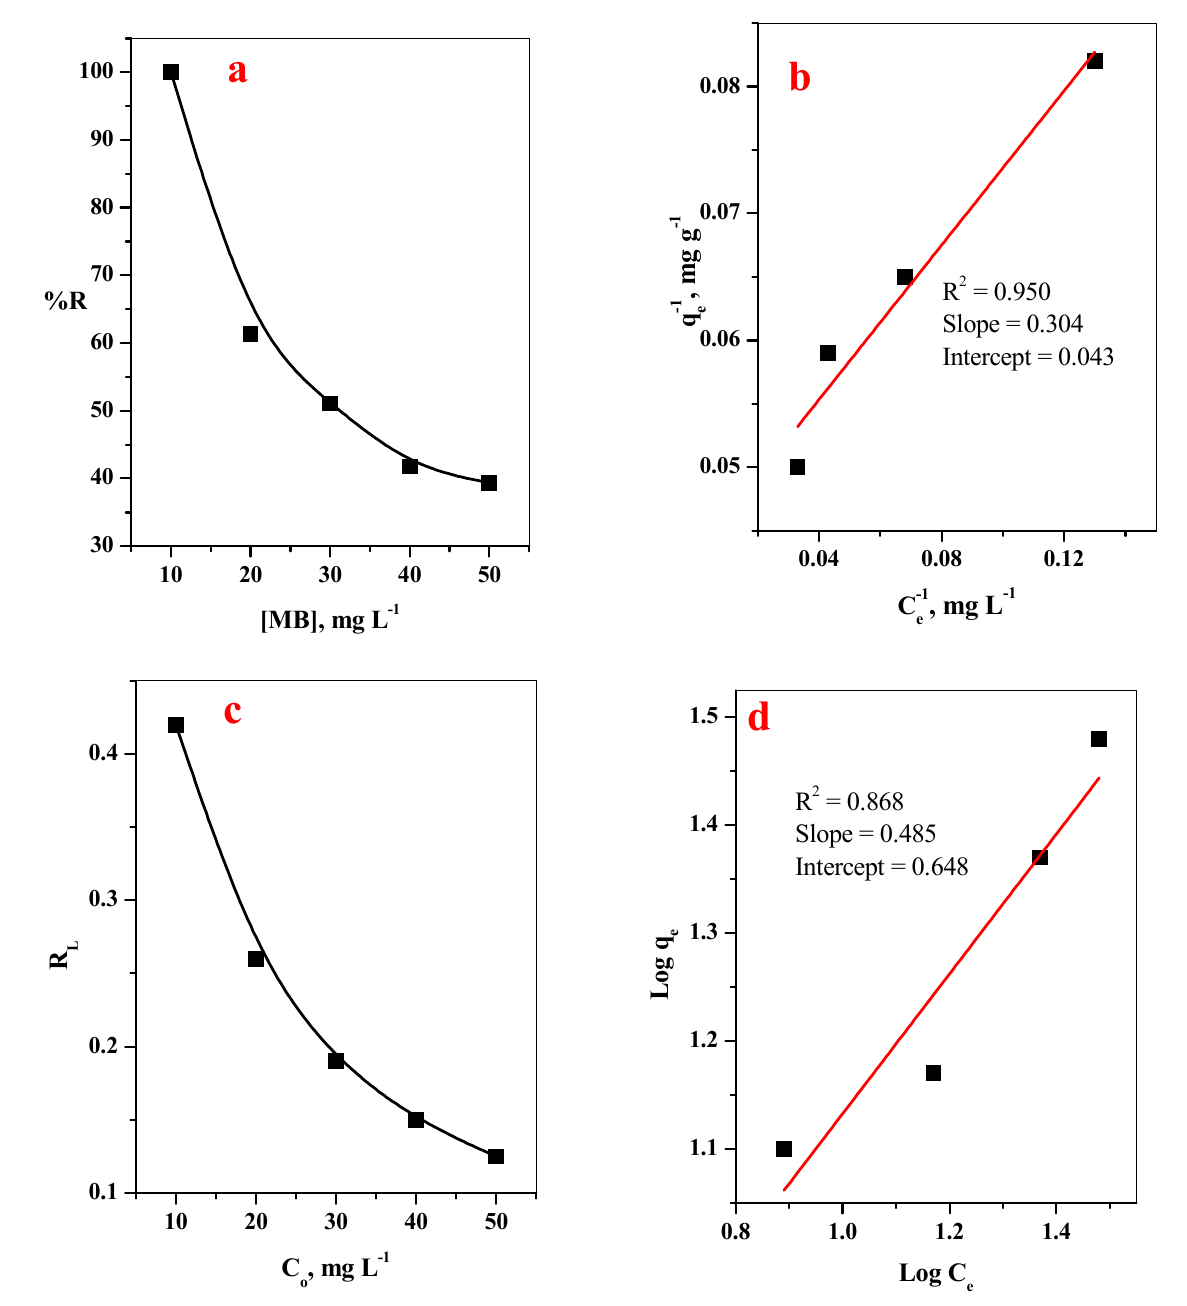
Figure 7. Effect of ( a ) dye concentration on removal percent, ( b ) Langmuir isotherm plot, ( c ) R L , ( d ) Freundlich isotherm plot of MB dye. (t = 35 min, [GO@CS] = 50 mg/10 mL, pH = 7, T = 25 ◦